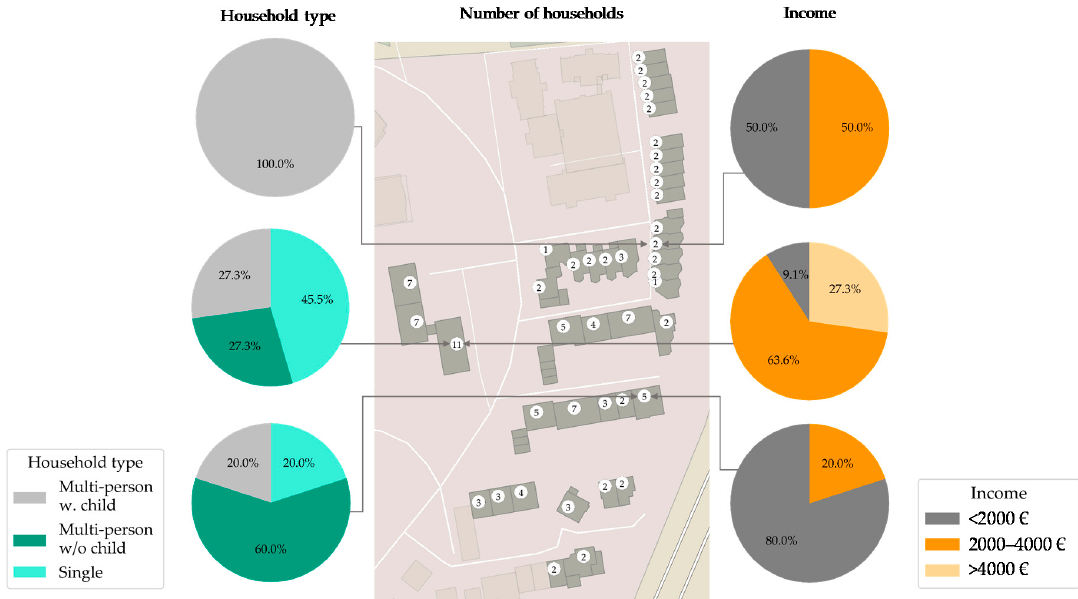
Figure 7. Household distribution in a street section in Wiesbaden, pie charts showing frequency distribution of income and household type for specific buildings. Map data copyright OpenStreetMap contributors (www.openstreetmap.org/copyright).